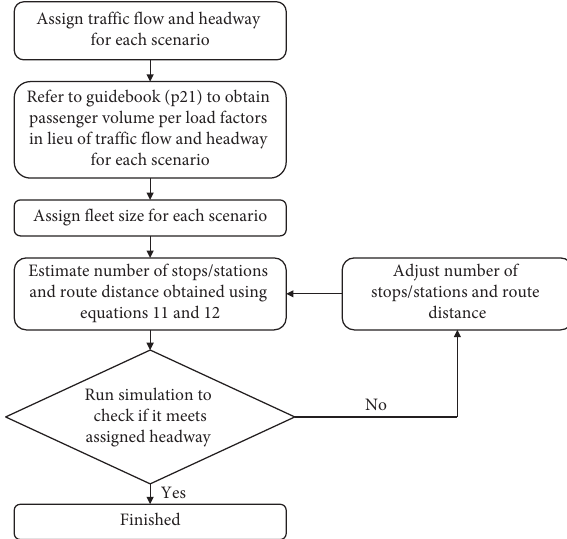
Figure 6: Procedure for design scenarios. Table 1: Parameter and passenger volumes per hour for three